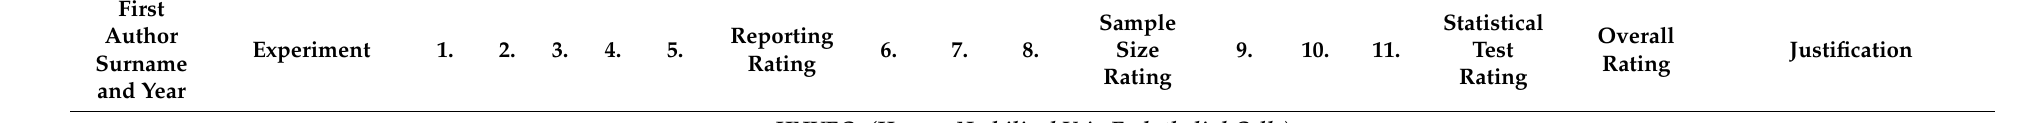
Table A3. Imprecision Tool Assessments on Selected